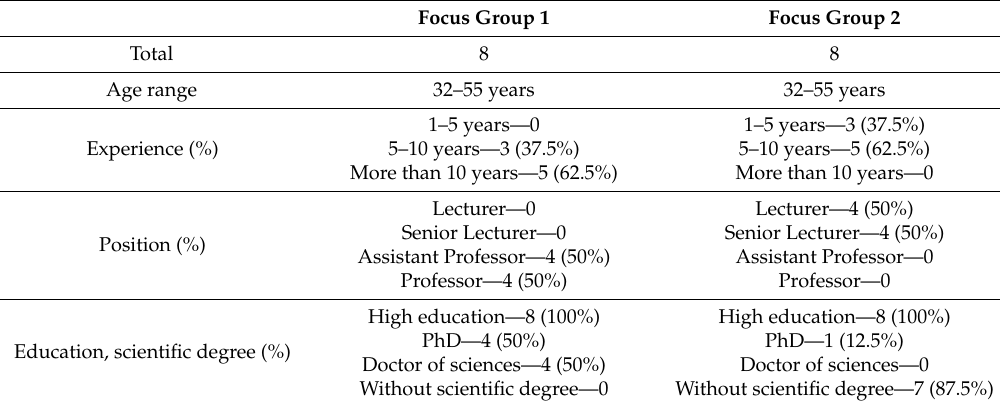
Table 5. Focus groups